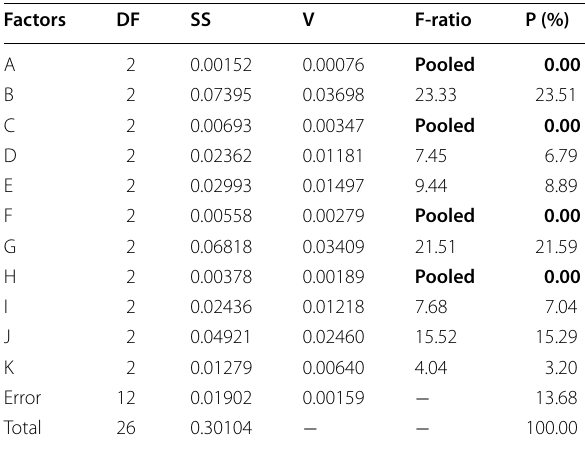
Table 5 Pooled ANOVA for the grey relational grade (GRG)